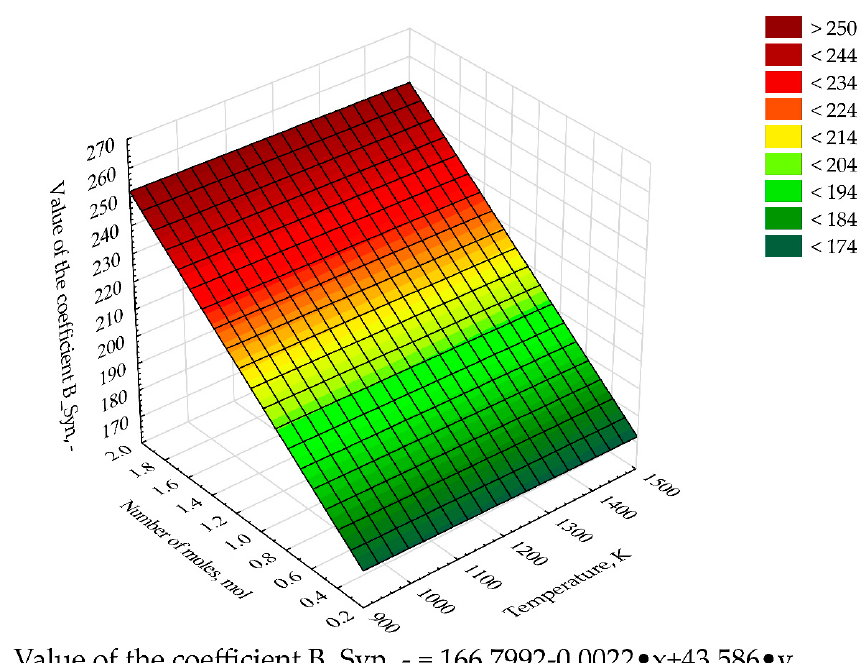
Figure 11. Value of the syngas compression ratio as a function of the number of moles of the gasification agent (x) and the temperature (y) of the gasification process using H 2 O.